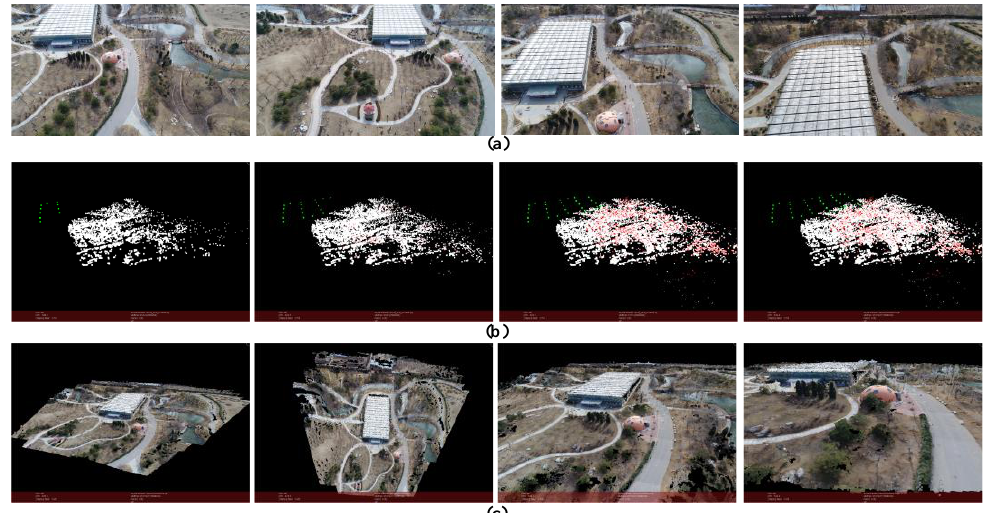
Figure 16. Reconstruction result of botanical garden. ( a ) Part of the images used for reconstruction; ( b ) Structure calculation of image queue SfM (green points represent the positions of camera); ( c ) Dense point cloud of the scene.